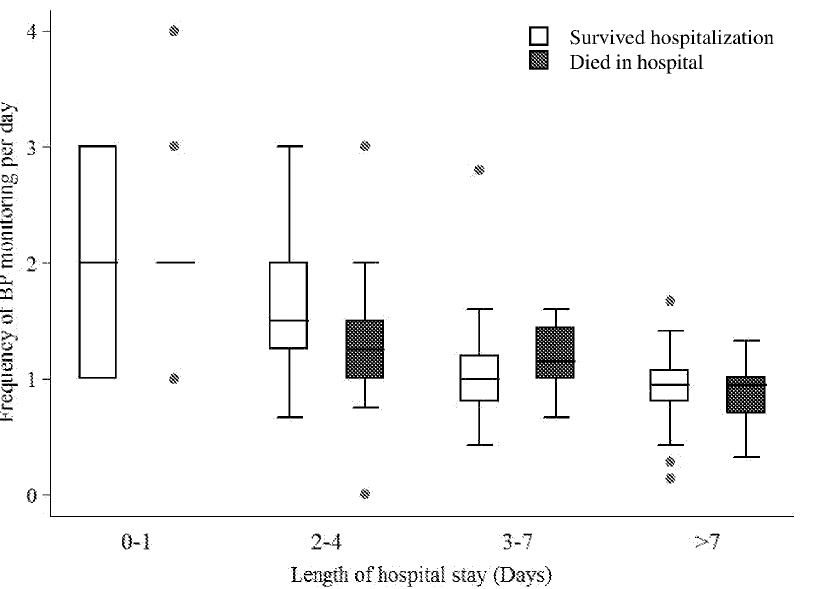
Figure 2. Frequency of blood pressure monitoring over the course of hospitalization according to final in-hospital vital status.